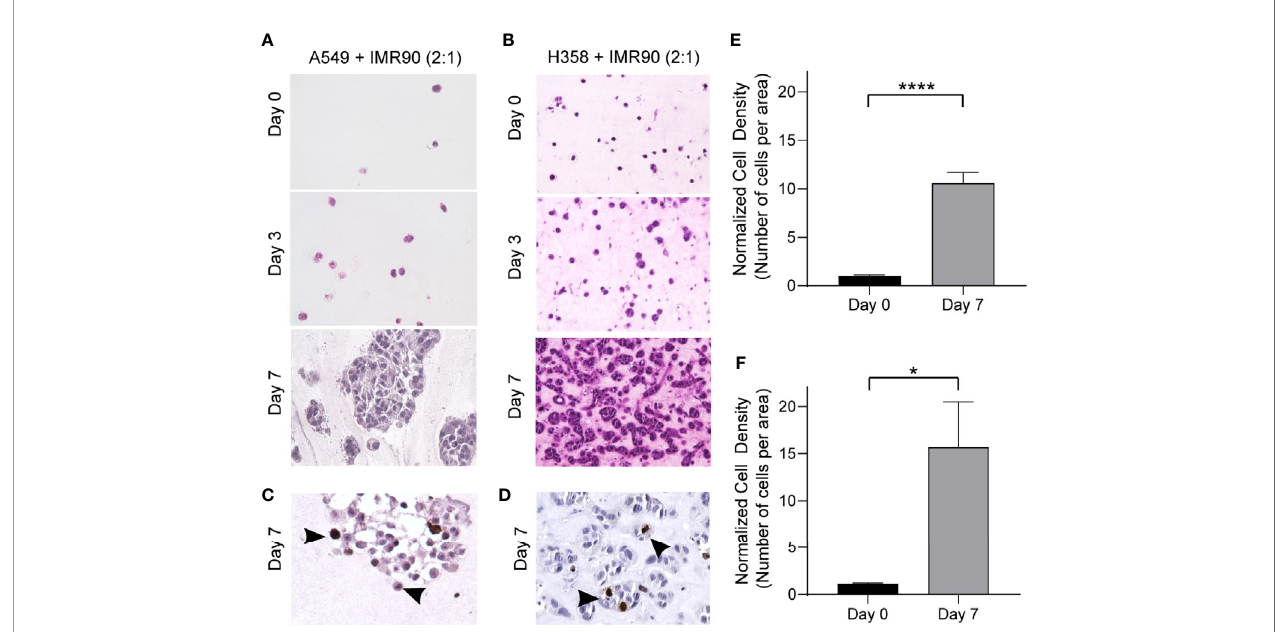
FIGURE 2 | 3D Culture Establishes a TME Allowing for Growth over 7 Days Culture. (A, B) Photomicrographs of H&E cross-sections showing increased cell density over time for tumor mimics containing, A549 tumor cells and IMR90 fi broblasts (2:1 ratio, A ) or H358 tumor cells and IMR90 fi broblasts (2:1 ratio, B ) within an ECM containing 90% enzyme extracted bovine collagen (~6 mg/mL) and 10% basement membrane proteins (growth factor reduced Matrigel). (C, D) Representative photomicrographs of immunohistochemical staining for Ki-67 following 7 days culture in A549 + IMR90 tumor mimics (C) and H358 + IMR90 tumor mimics (D) showing actively proliferating cells in both tumor mimics. (E, F) Cell density, or the number of nucleated cells per area, normalized to the starting (Day 0) cell density in A549 + IMR90 tumor mimics (E) and H358 + IMR90 tumor mimics (F) increases between days 0 and 7. n= 3-6 replicates per experiment. *p<0.05, **** p<